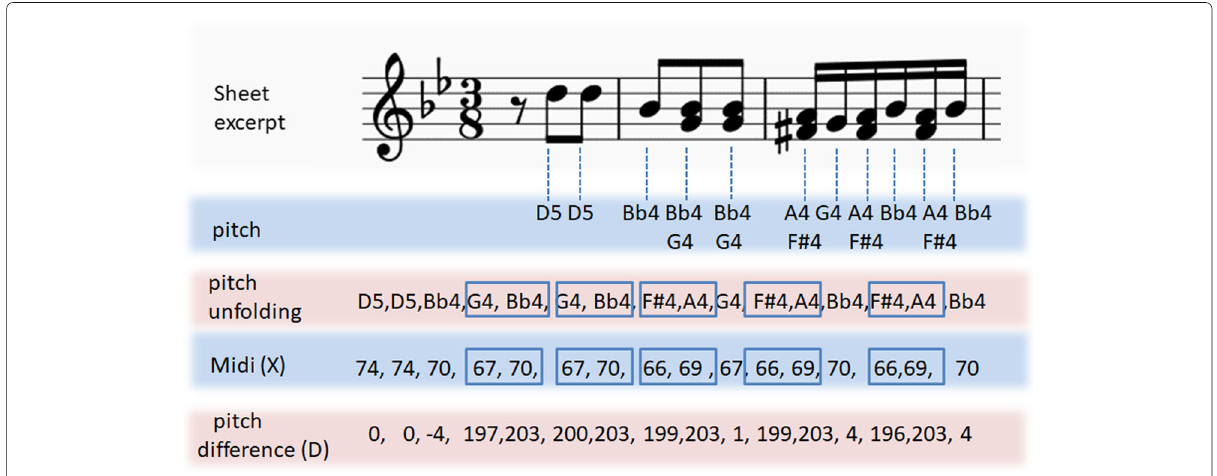
Fig. 2 Computing of pitch difference sequence excerpted from a